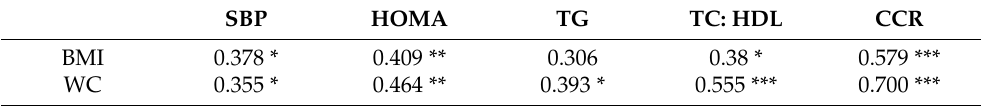
Table 2. South Asian partial correlations (adjusted for Gender, Age, Maturation, and Physical Activity levels) for individual CVD risk factors and clustered cardiometabolic risk with BMI and